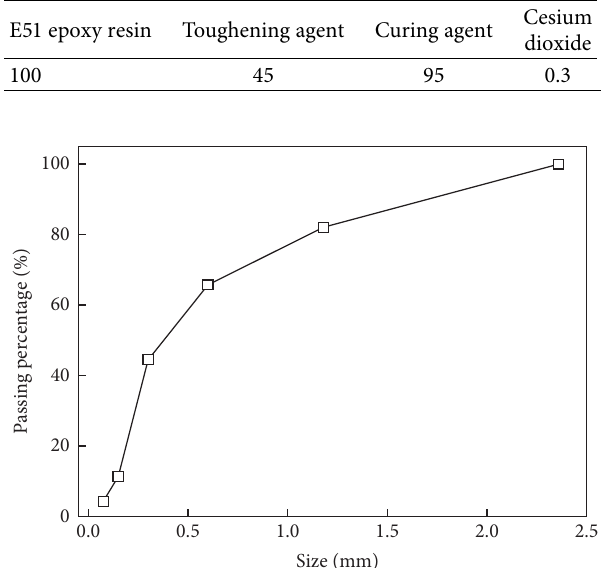
Figure 1: Particle size distribution of rubber